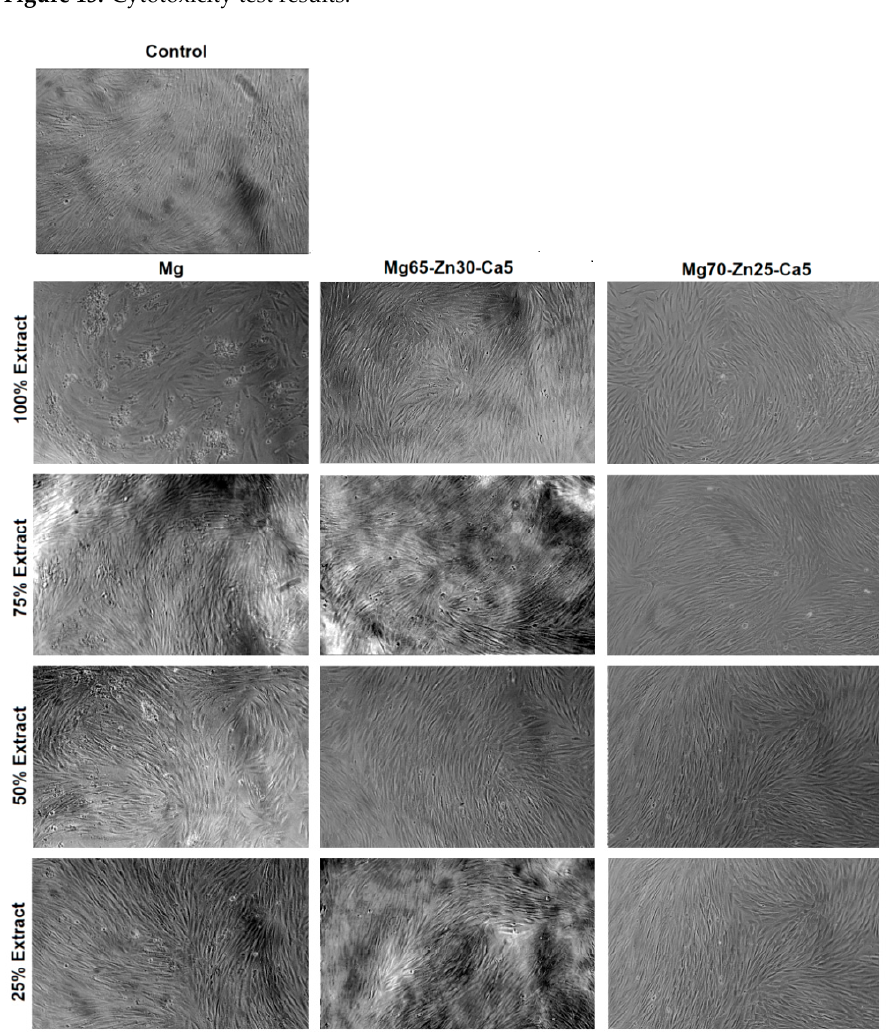
Figure 14. Morphology and proliferation of cultured fibroblasts after 96 h (enhanced contrast).